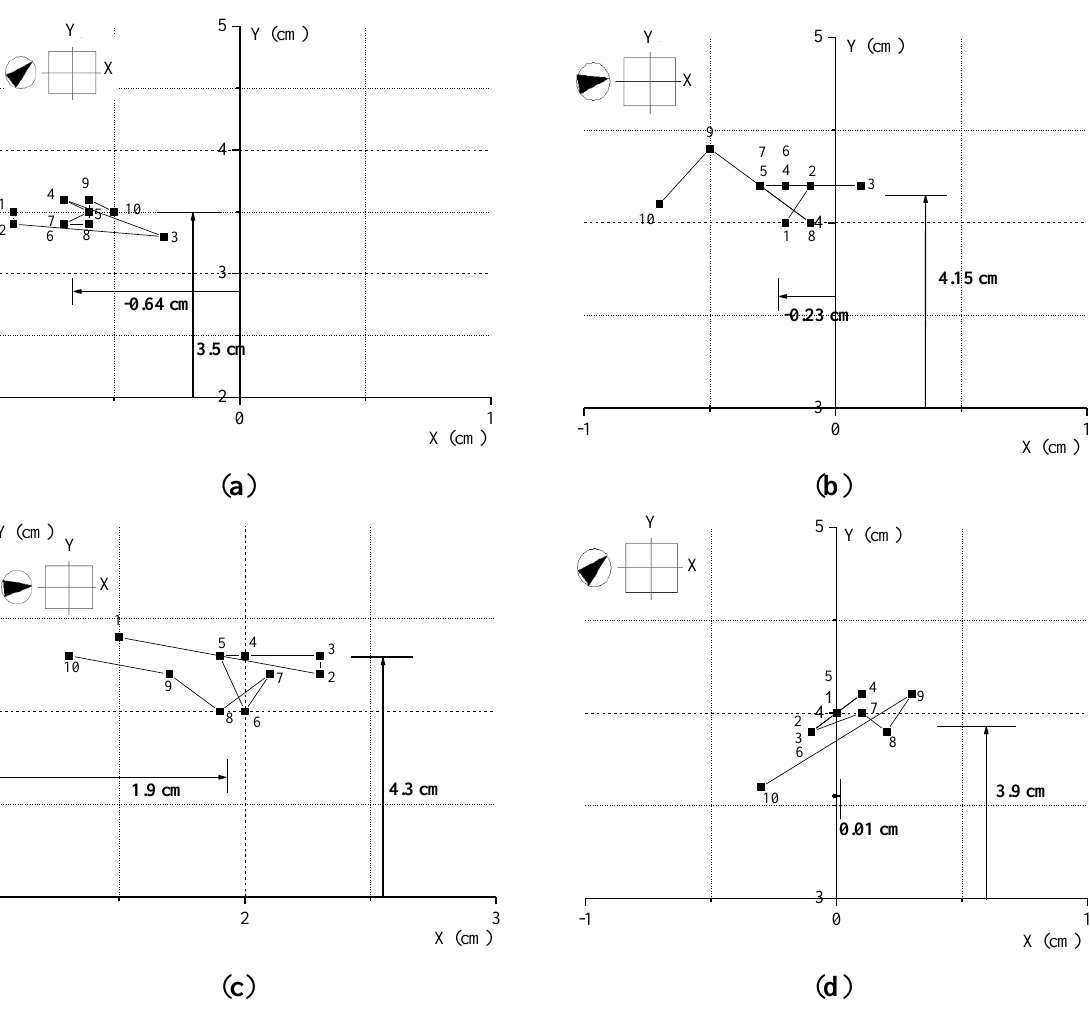
Figure 7. Measured displacements for different mean wind speed at limited time